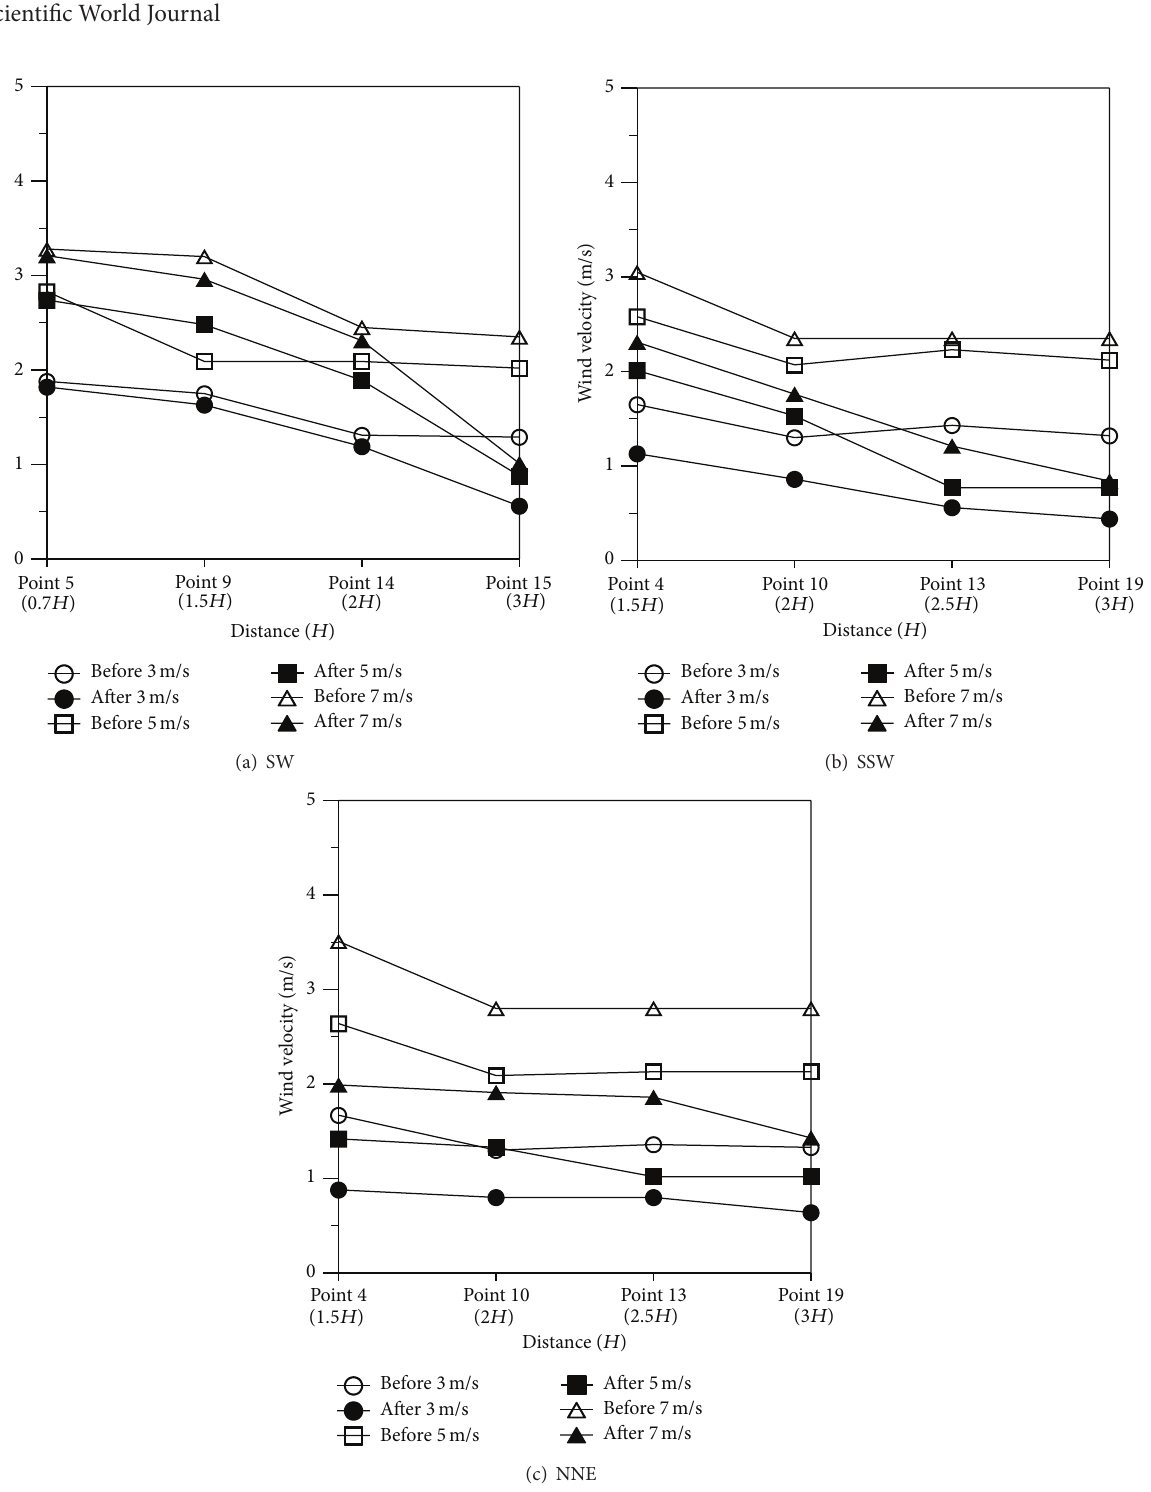
velocity of 3.4 m/s in March (as observed in the nearest meteorological observatory). In the field experiment, wind velocity and temperature distribution were identified focus- ing on the lowest point ( − 11.5 m) and the highest point (1.2 m) of the embankment. Figure 10 shows the location of the field